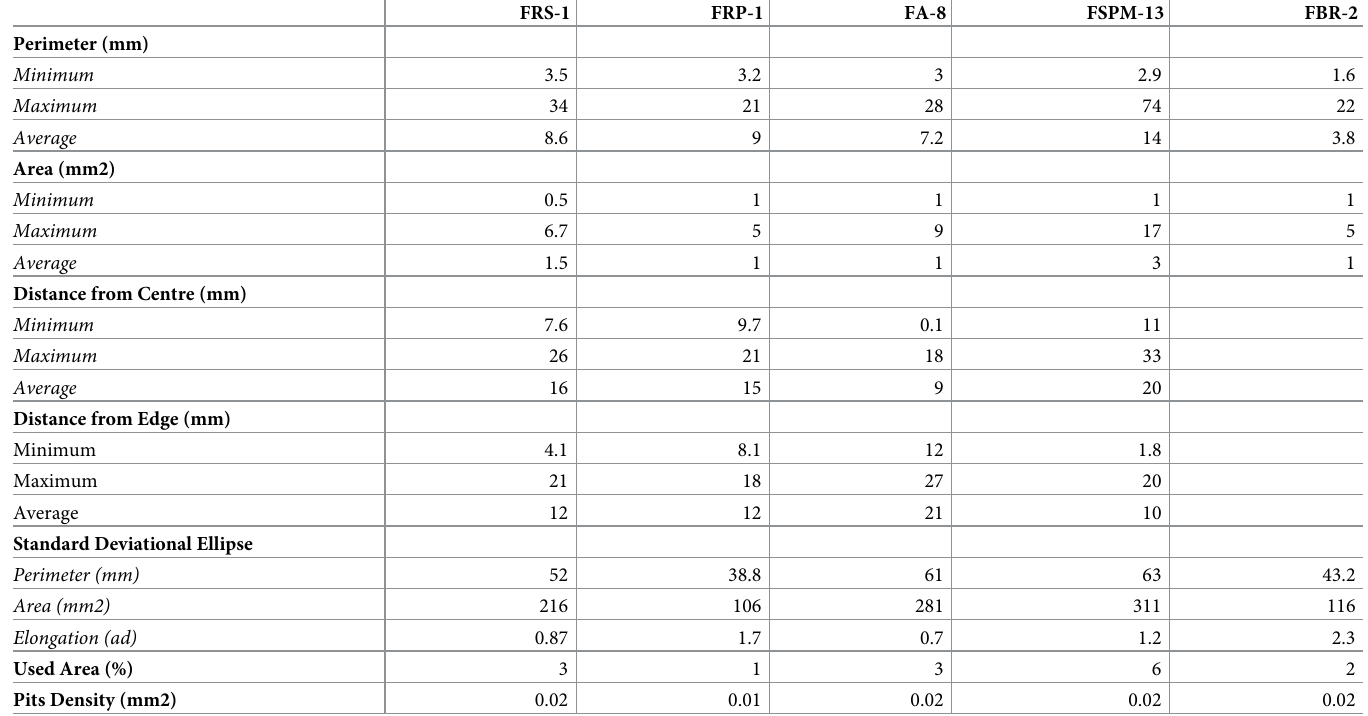
Table 3. Morphometric features of the wear identified on the utilised areas of the experimental replicas. In detail, scaled retouch (FSR-1), marginal retouch (FRP-1), bipolar percussion (FA-8), striking platform maintenance (FSPM-13) and bladelet removal